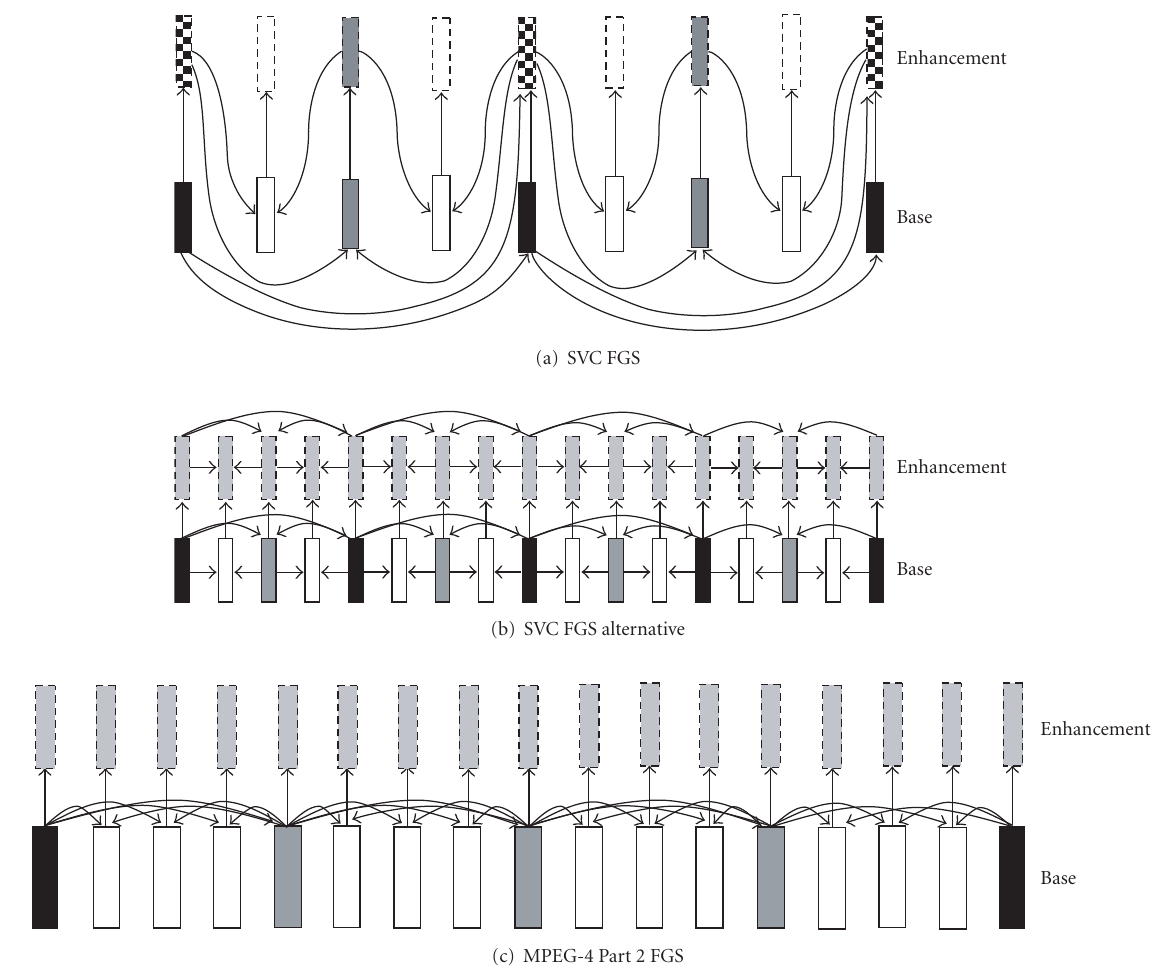
Figure 3: Fine granularity scalability (FGS) prediction